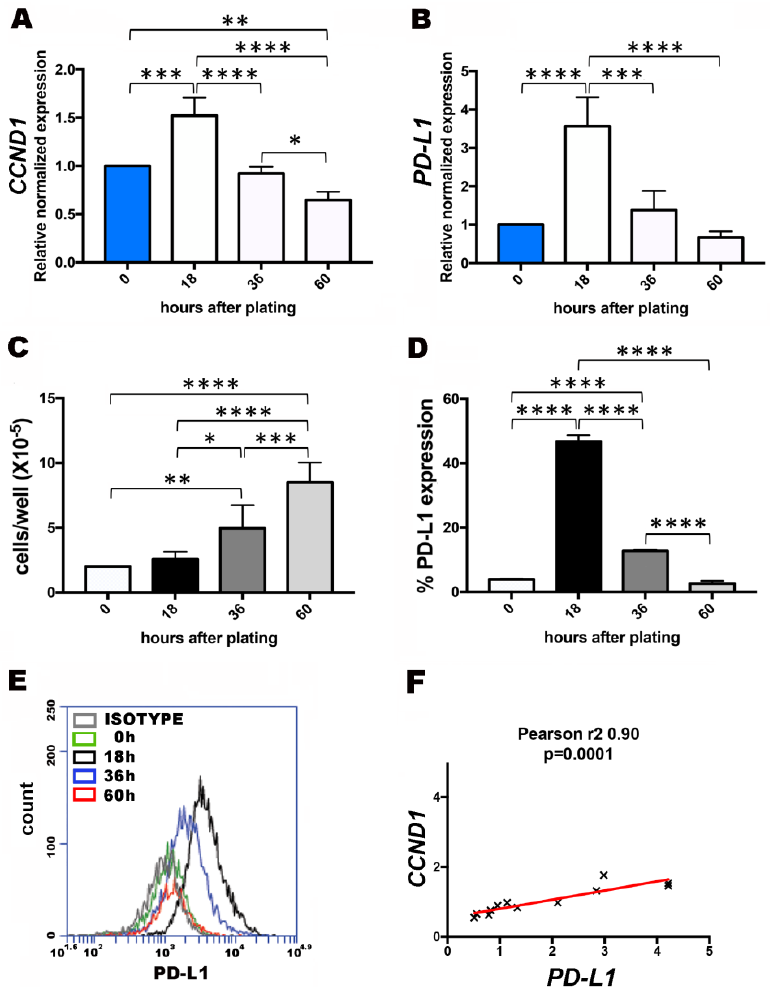
Figure 2. Changes in PD-L1 expression correlate with cyclin D expression, in U251MG cell culture. ( A ) Analysis by qPCR of CCND1 expression level (T0 = control sample, expression = 1). ( B ) Analysis by qPCR of CCND1 expression level (T0 = control sample, expression = 1). ( C ) Cell counting. ( D ) Flow cytometric analysis of PD-L1 expression. Cells were collected at 0h (seeding), 18 h, 36 h, 60 h after plating. ( E ) Representative histograms of PD-L1 expression are shown in overlay. ( F ) Linear regression of PD-L1 and CCND1 transcript levels (relative normalized expression, T0 reference sample). Data are mean ± SD (N = 3). * p < 0.05, ** p < 0.01, *** p < 0.001, **** p <